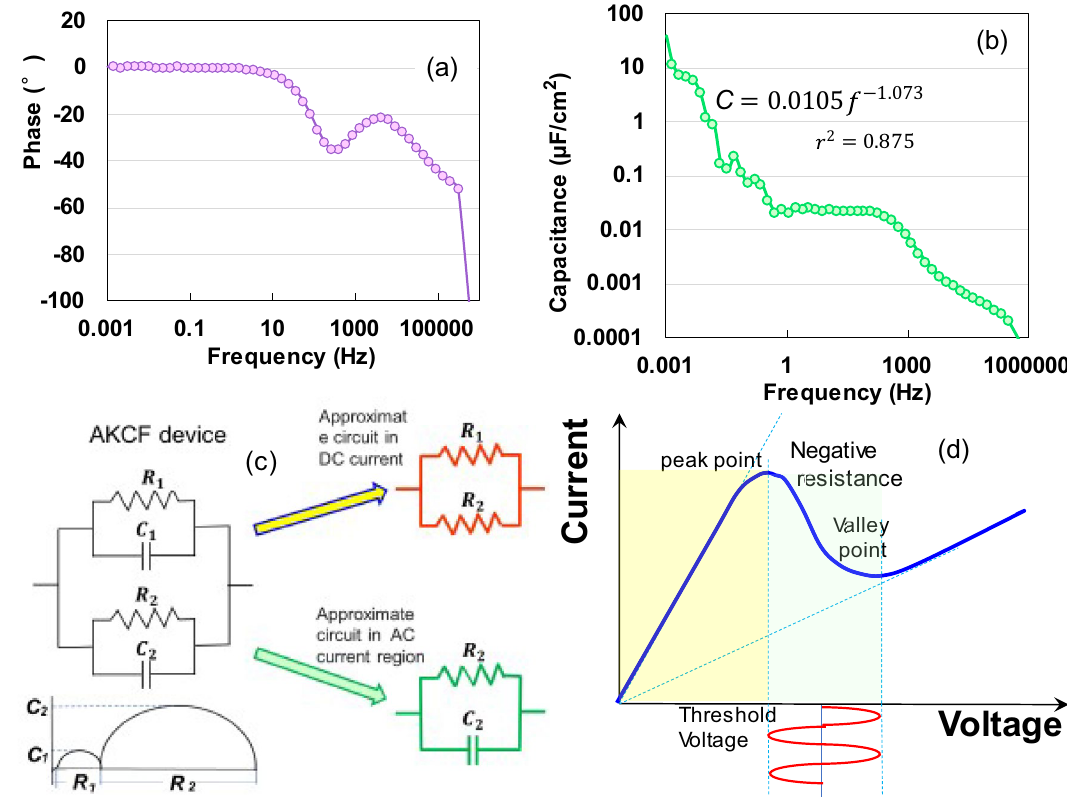
Figure 4. Frequency dependence of ( a ) phase angle and ( b ) parallel capacitance; ( c ) equivalent circuit corresponding to the Nyquist diagram in Fig. 3c and approximate circuits in DC and AC current regions; ( d ) schematic diagram of I–V characteristics estimated as Gunn